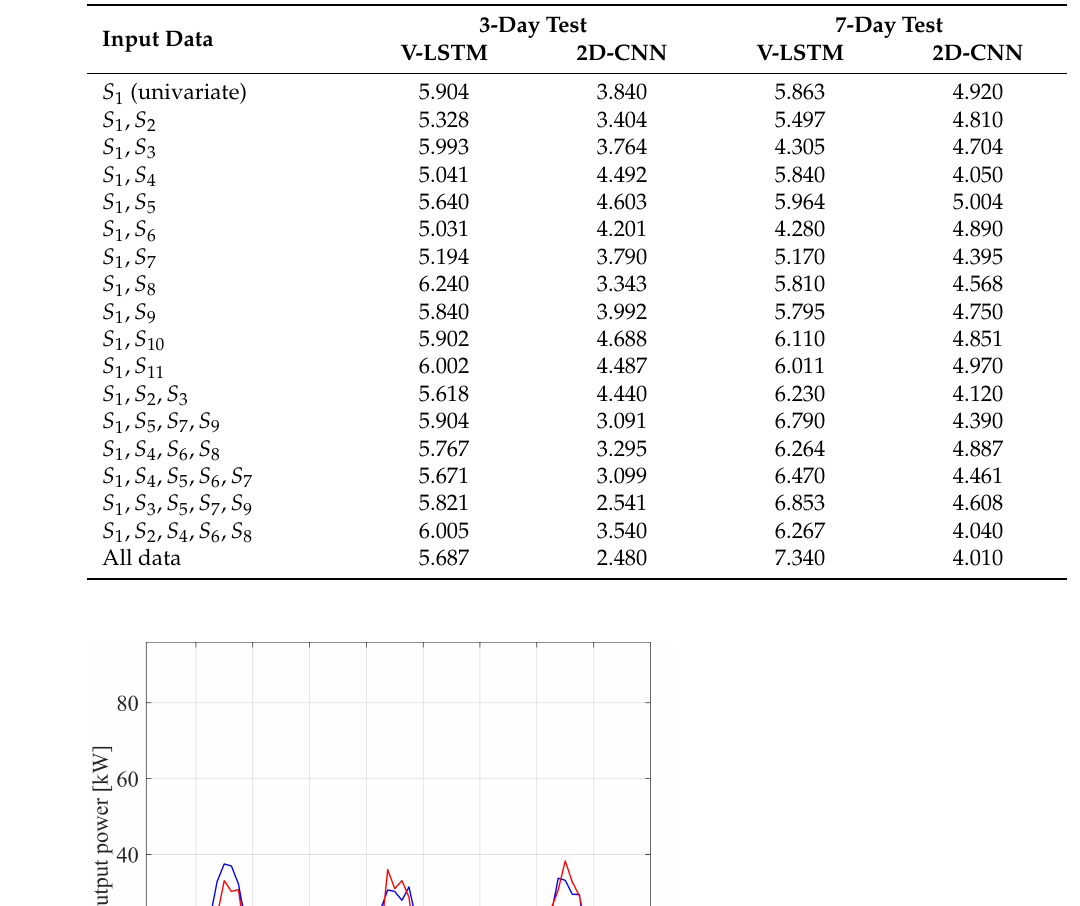
Table 9. Average RMSE for December 2018 tests, carried out by using V-LSTM and 2D-CNN models and different combinations of time series.